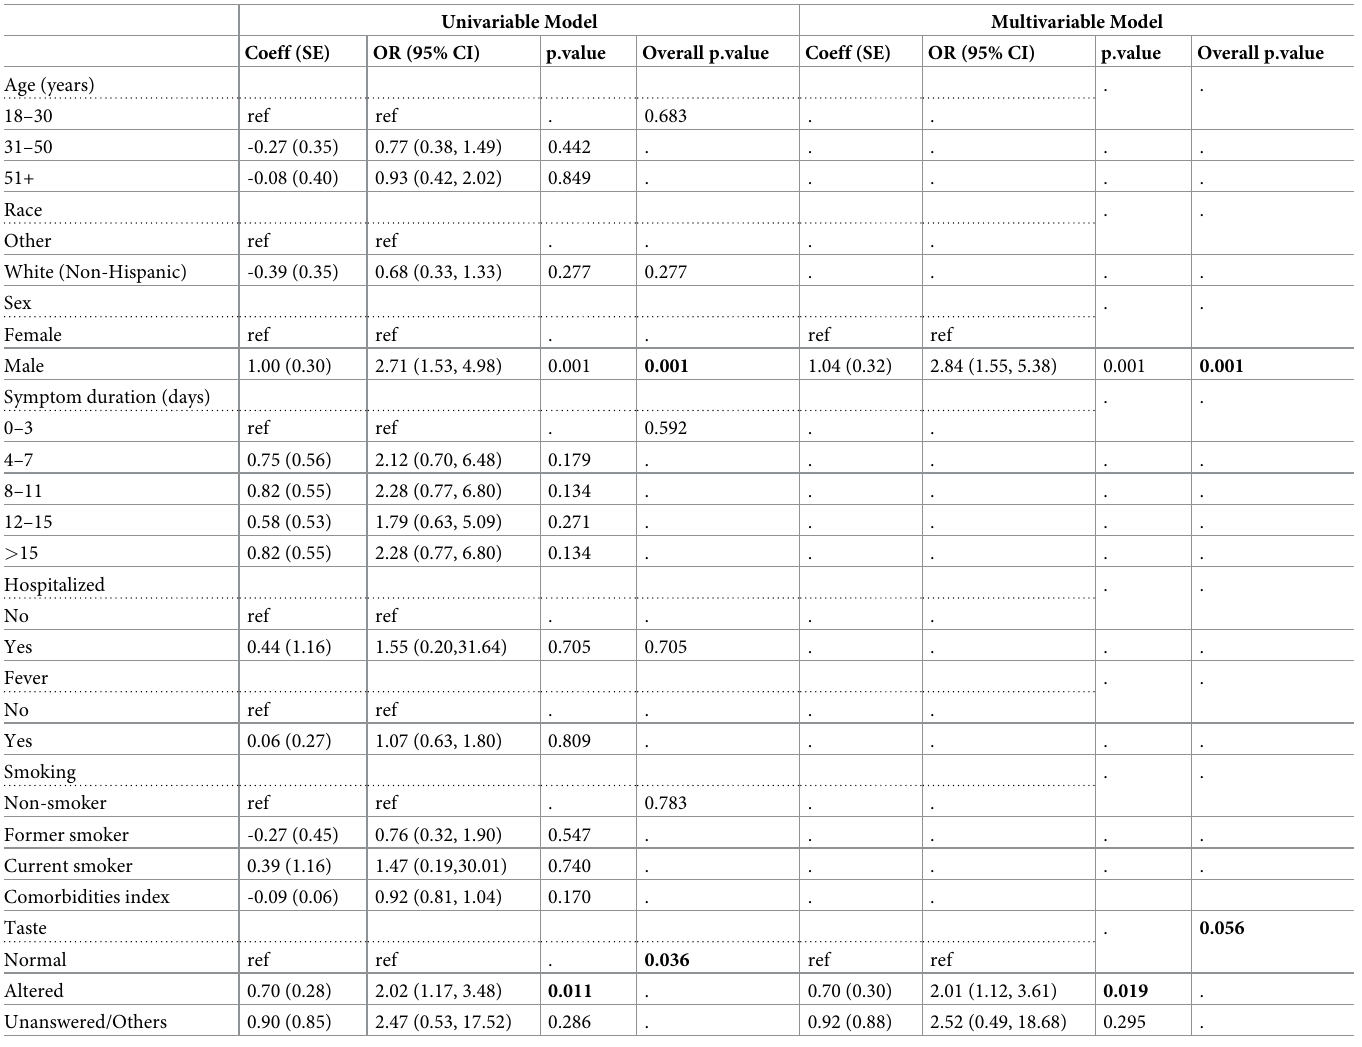
Table 4. Univariable and multivariable logistic models using TASTE as the main predictor. Univariable Model Multivariable Model Coeff (SE) OR (95% CI) p.value Overall p.value Coeff (SE) OR (95% CI) p.value Overall p.value